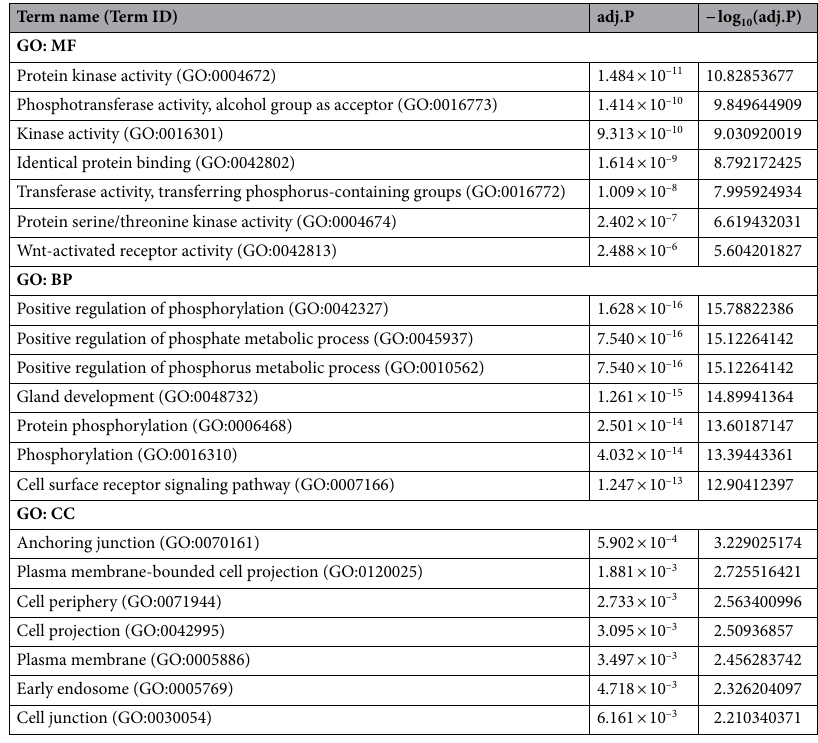
Table 6. GO (Gene Ontology) enrichment analysis for up-regulated DEGs.